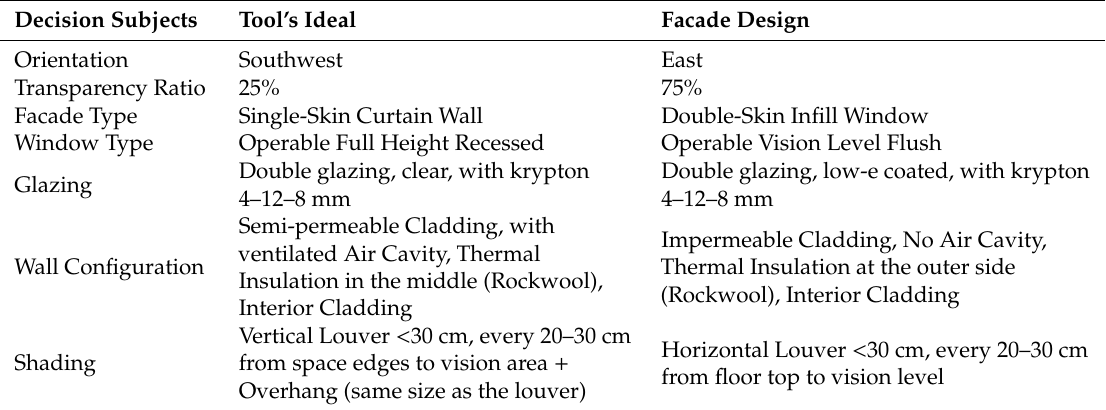
Table 3. Comparison of design decisions for